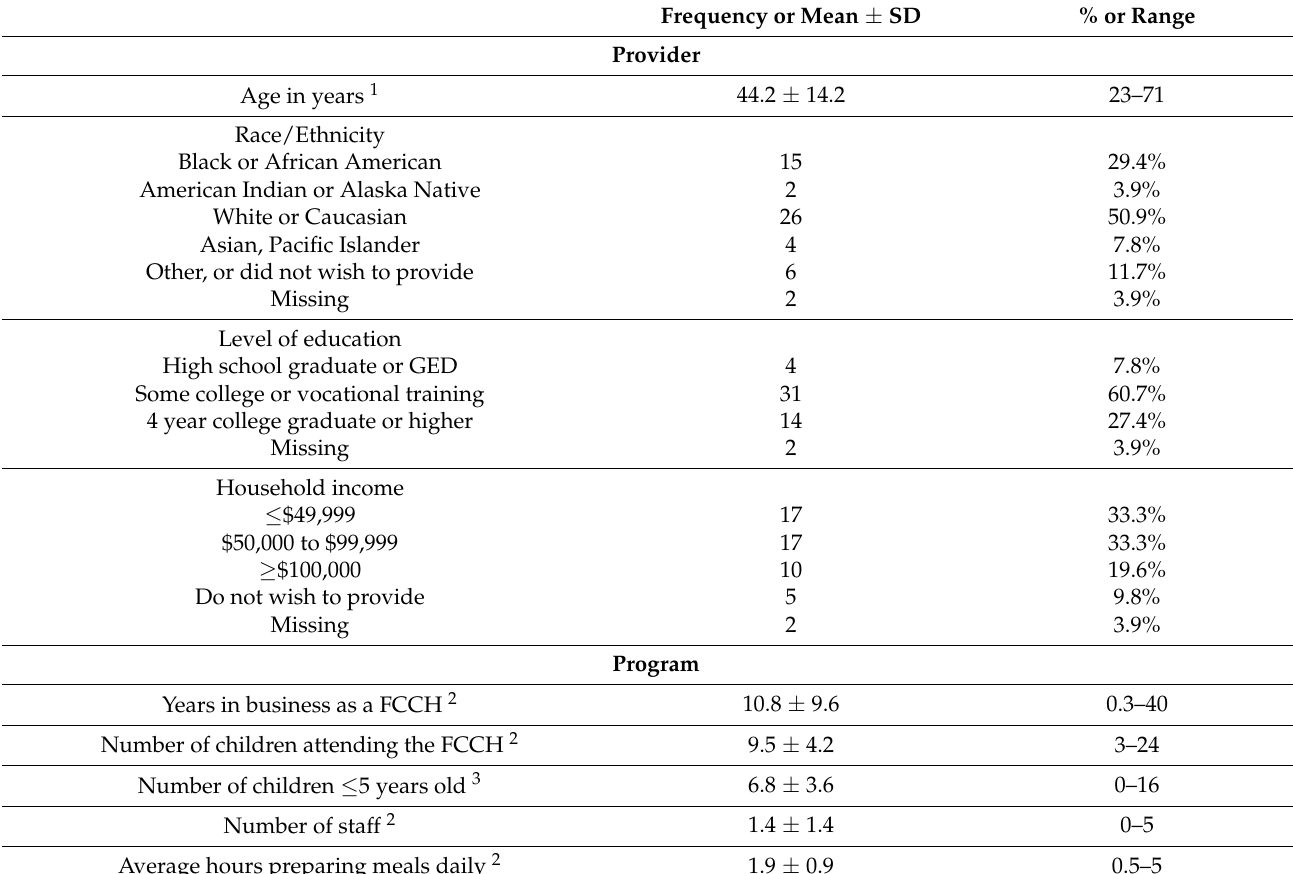
Table 1. Demographic Characteristics of Family Child Care Home (FCCH) Providers in and around Oklahoma City, Oklahoma Participating in Happy Healthy Homes Baseline Measures Fall 2017–Fall 2018 ( n =